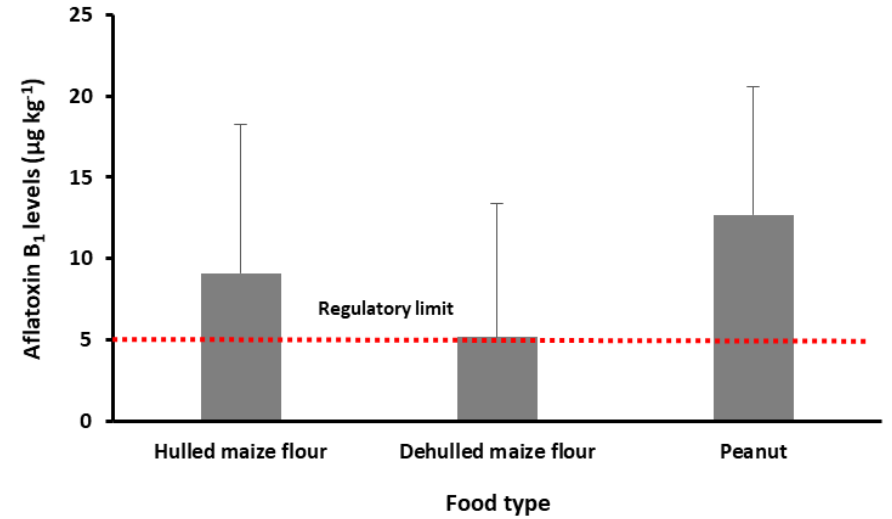
Figure 2. Aflatoxin B 1 levels in maize flour and peanut samples from Kabale and Kisoro, southwestern Uganda, and the East African regulatory limit (red dotted line). Values are means ± standard deviation ( n =